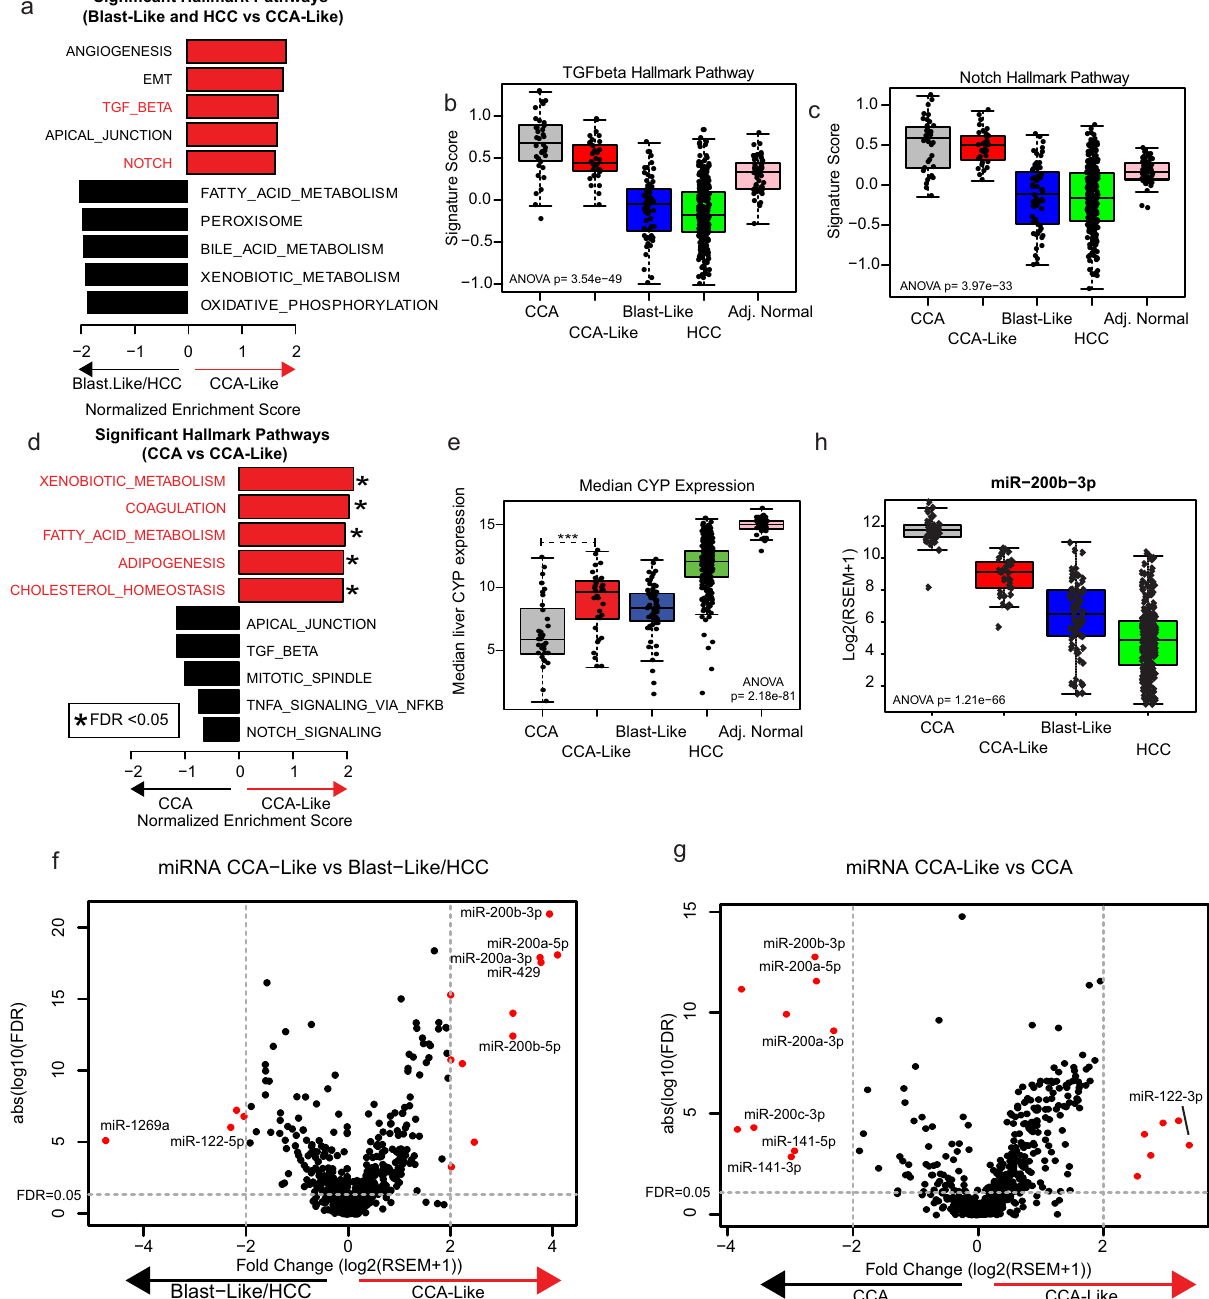
Fig. 4 CCA-Like tumors display features of transdifferentiation. a Gene Set Enrichment Analysis was performed (CCA-Like vs. Blast-Like and HCC) using the Hallmark gene sets. Seven gene sets were enriched in CCA-Like versus Blast-Like and HCC. Gene sets associated with transdifferentiation are noted in red. b , c Signature scores associated with transdifferentiation pathways, TGF β and Notch are plotted by tumor classi fi cation. One-way ANOVA p -values are shown. d Gene set enrichment analysis comparing CCA-Like vs. CCA using the hallmark gene sets. Liver-speci fi c gene sets are noted in red. e The median expression of liver-speci fi c cytochrome P450 genes are plotted by subtype, *** indicates p < 0.001 for two-sample t-test between CCA and CCA-Like. f − g Volcano plots for fold change vs FDR; are plotted for CCA-Like vs. Blast-Like and HCC and CCA-Like vs. CCA respectively; genes with fold change > 2 and FDR < 0.05 are indicated in red. h Per class expression of miR-200b-3p, a representative family member of the miR-200 family is plotted, p -value represents ANOVA. Boxes represent the IQR with the median represented by the bolded bar. Error bars represent Q1/Q3 ±